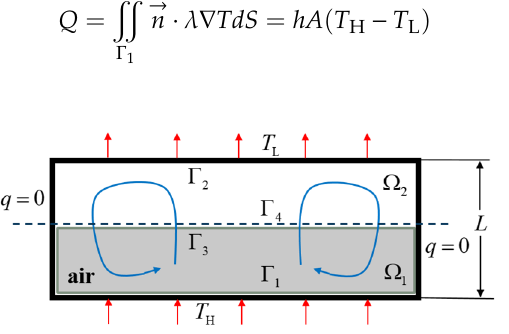
Figure 4. The schematic of closed cavity flow.